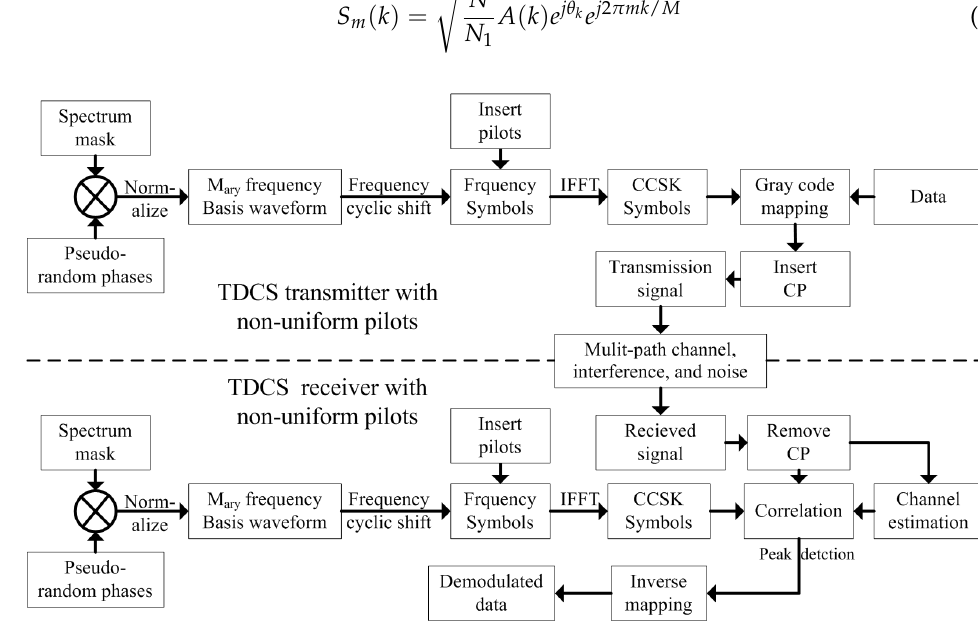
Figure 3. TDCS with non-uniform pilots.